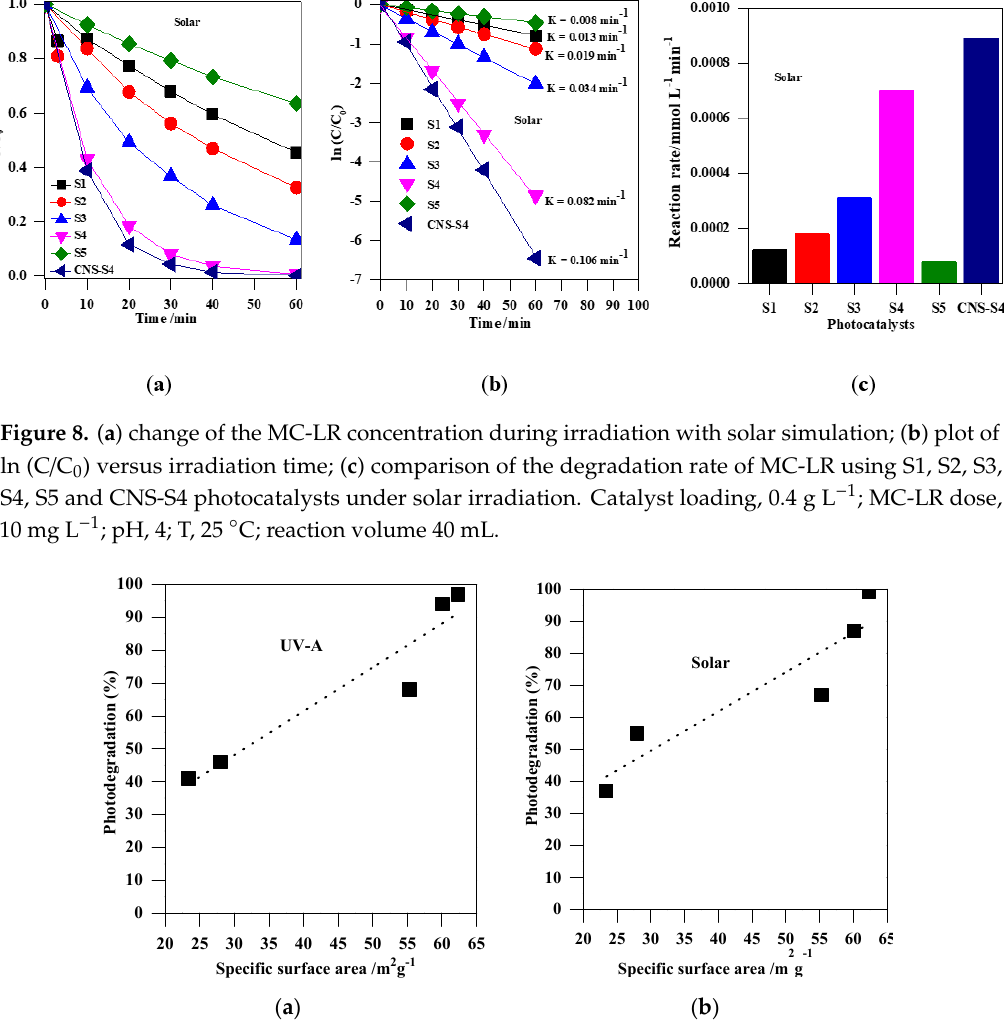
Figure 9 . Correlation between the photodegradation efficiency (%) and the specific surface areas of the non-modified TiO 2 photocatalysts: ( a ) under UV-A; and ( b ) under solar irradiation.